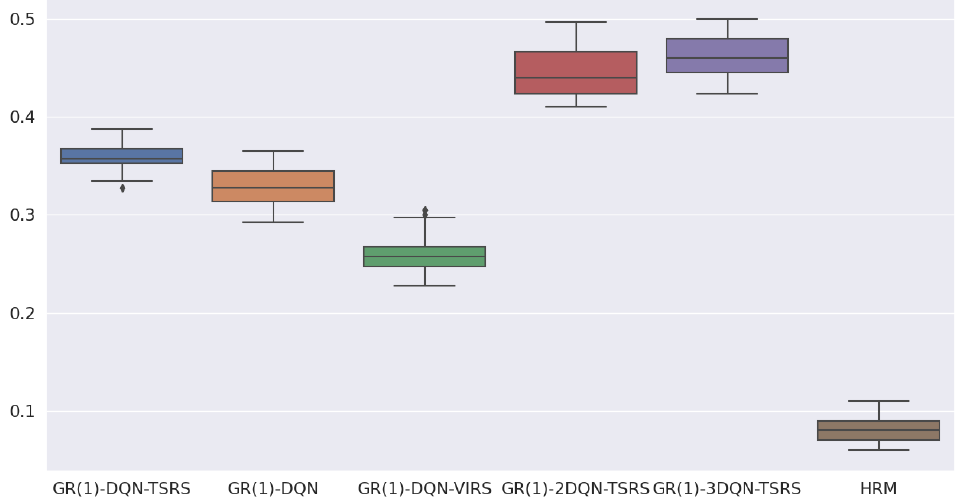
Figure 15. Box plot of learning curve for ϕ 2 under the environment setting 2.